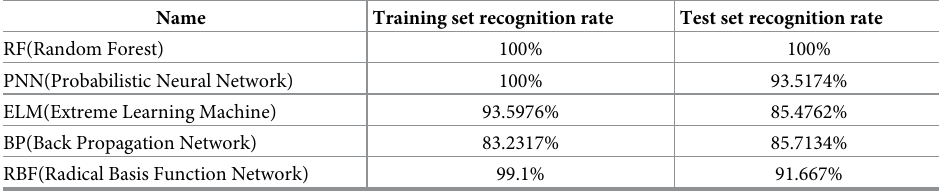
Table 10. Comparison of recognition